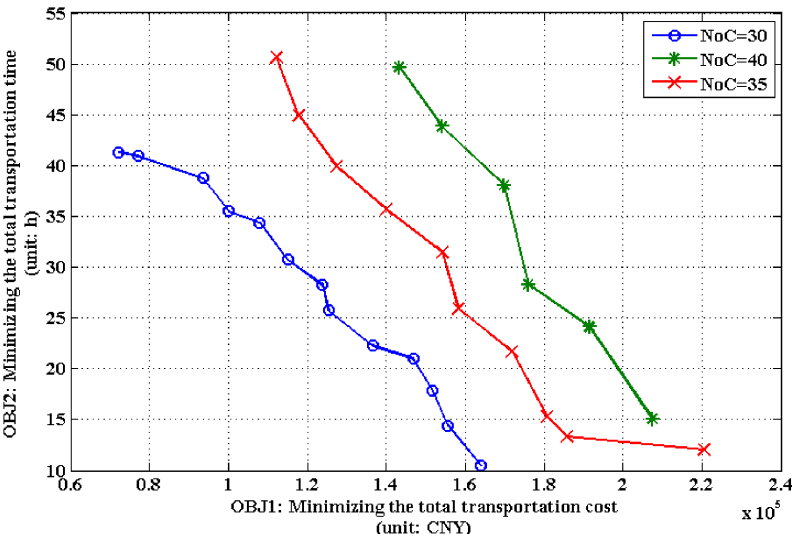
Figure 6. Sensitivity analysis of the goods volume on the Pareto